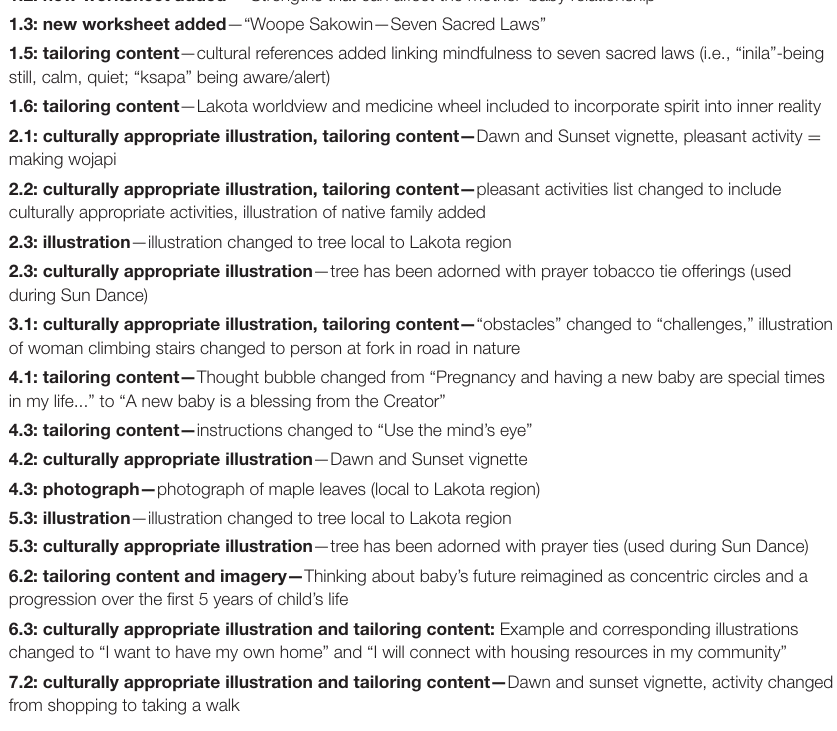
Both Cover Participant Introduction, Session